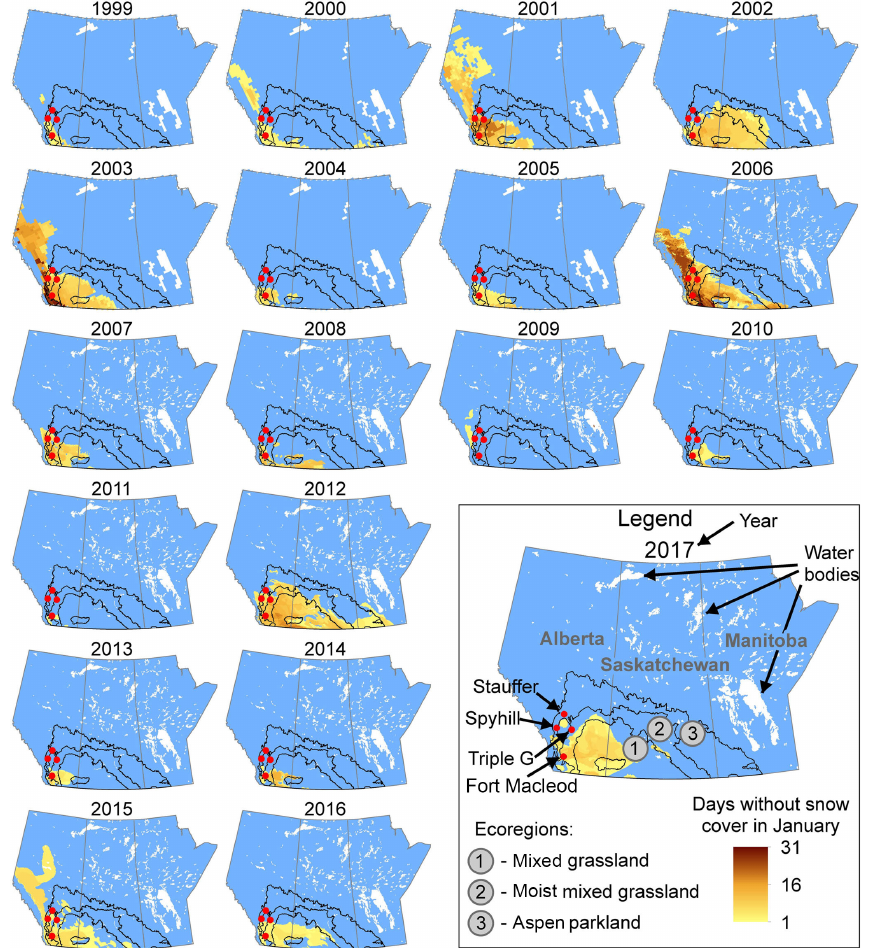
Figure 11. The occurrence of January snow-free period in the prairie provinces derived from the IMS data at 24km resolution (National Ice Center, 2008b) for 1999–2005 and at 4km resolution for 2006–2017 (National Ice Center, 2008a). Ecoregion boundaries are from Agri- culture and Agri-Food Canada (2003).